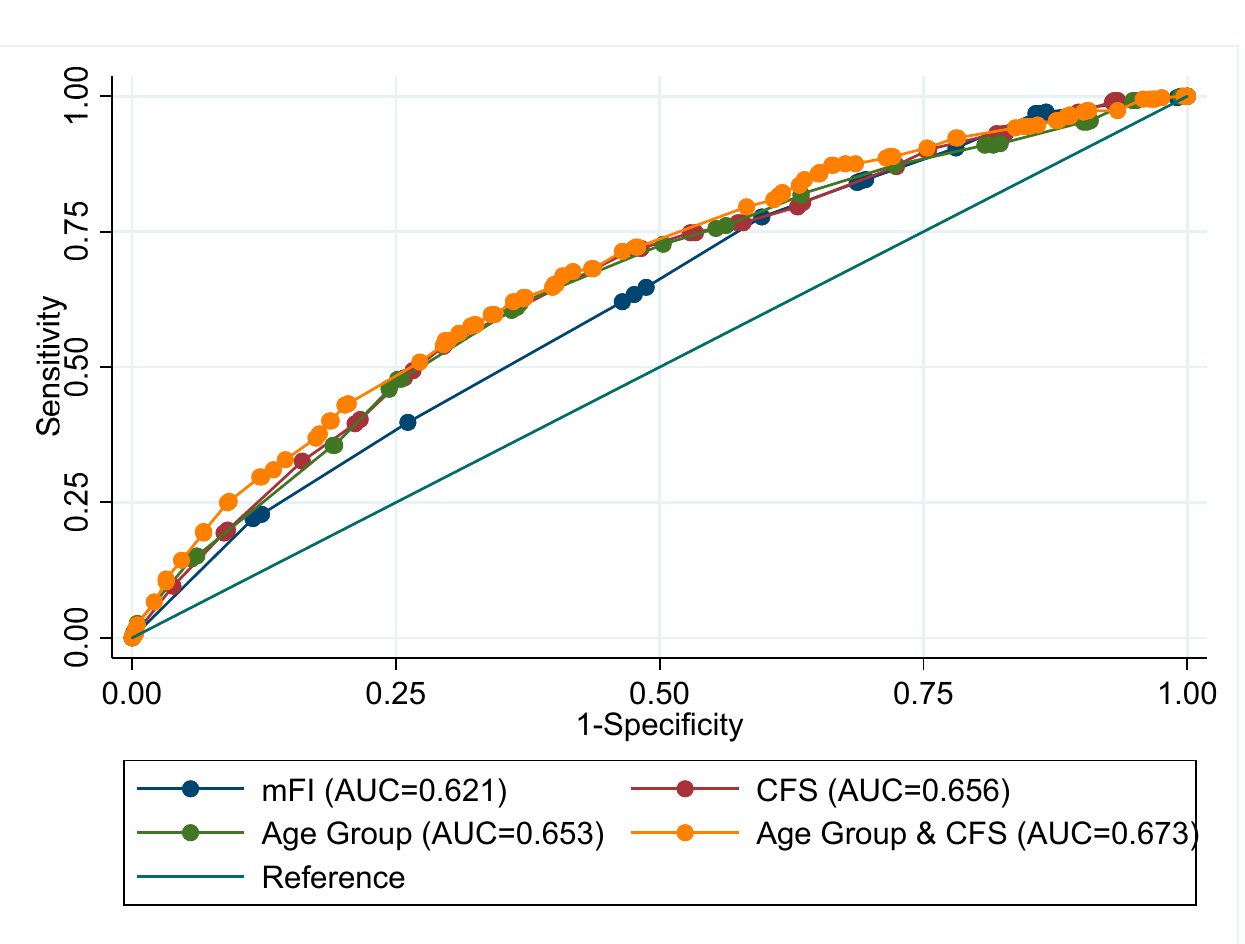
Figure 1. Receiver operating Area Under the Curve (AUC) for Day-28 mortality comparison of adjusted analyses fitting: Sex, smoking status, and elevated CRP.